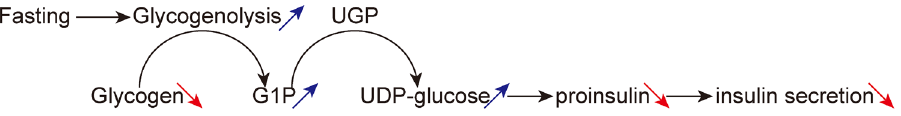
Figure 6. Possible model of fasting induced UDP-glucose- and cereblon-dependent proinsulin